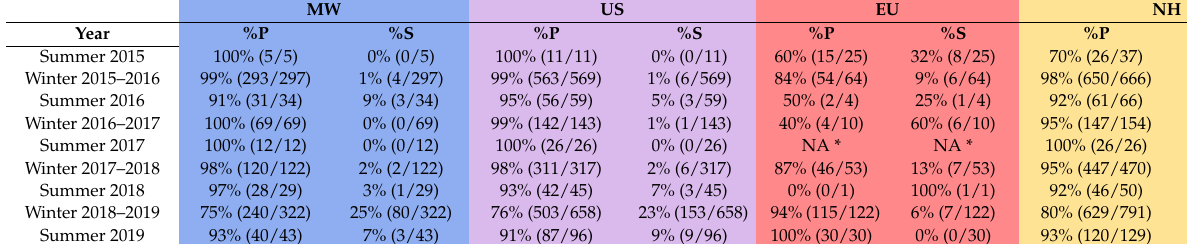
Table 4. Evolutionary timeline of hemagglutinin P154S variant by flu season and dataset, with the MW, US, EU, and NH datasets represented in blue, lavender, red, and yellow (respectively). MW US EU %P